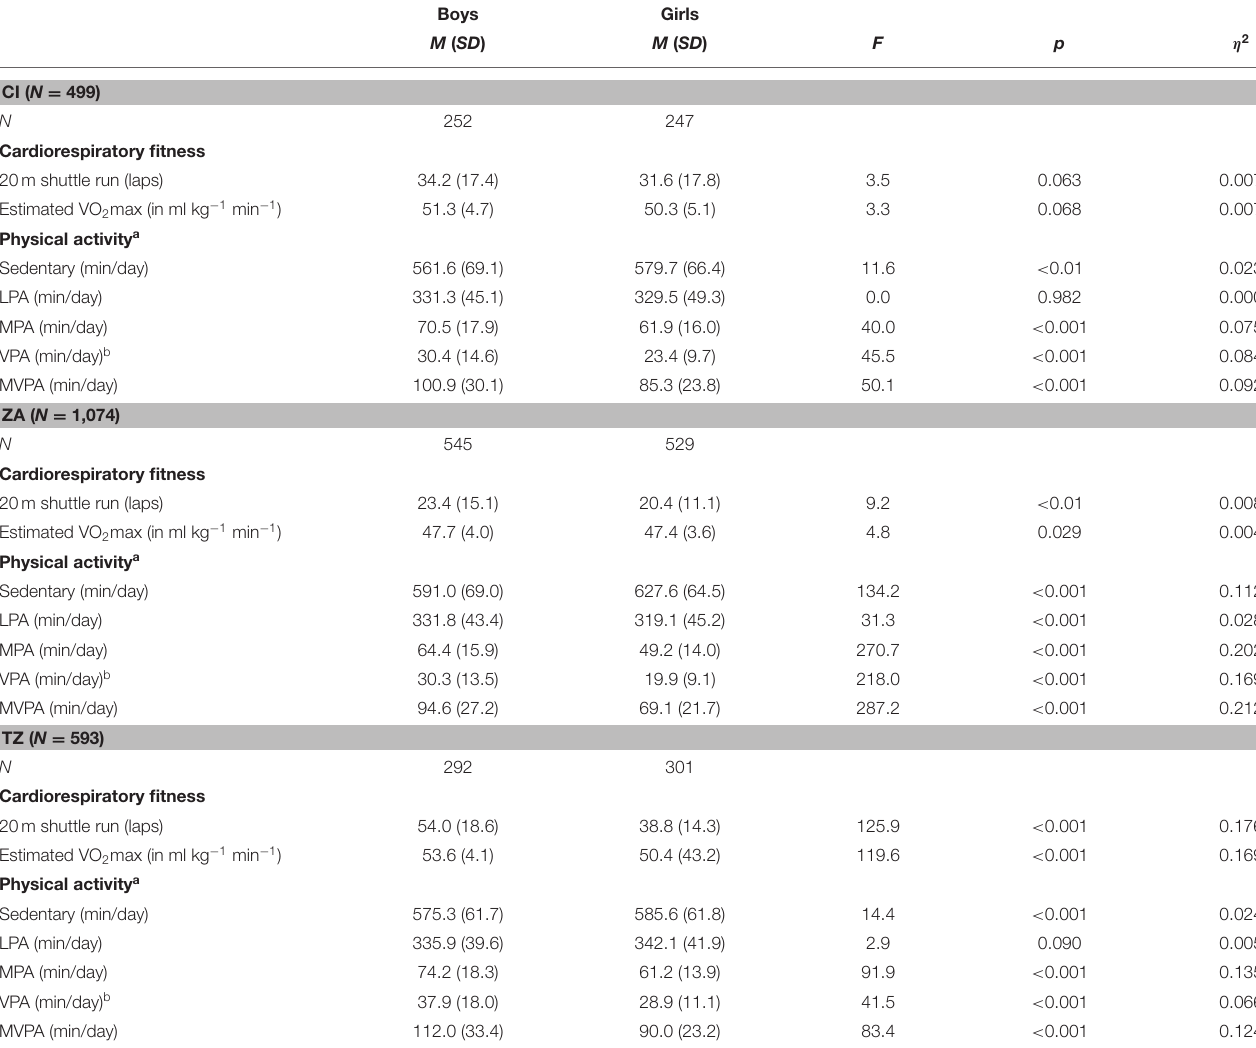
TABLE 3 | Descriptive statistics for boys and girls, separately for children from Côte d’Ivoire (CI), South Africa (ZA), and Tanzania (TZ). Boys